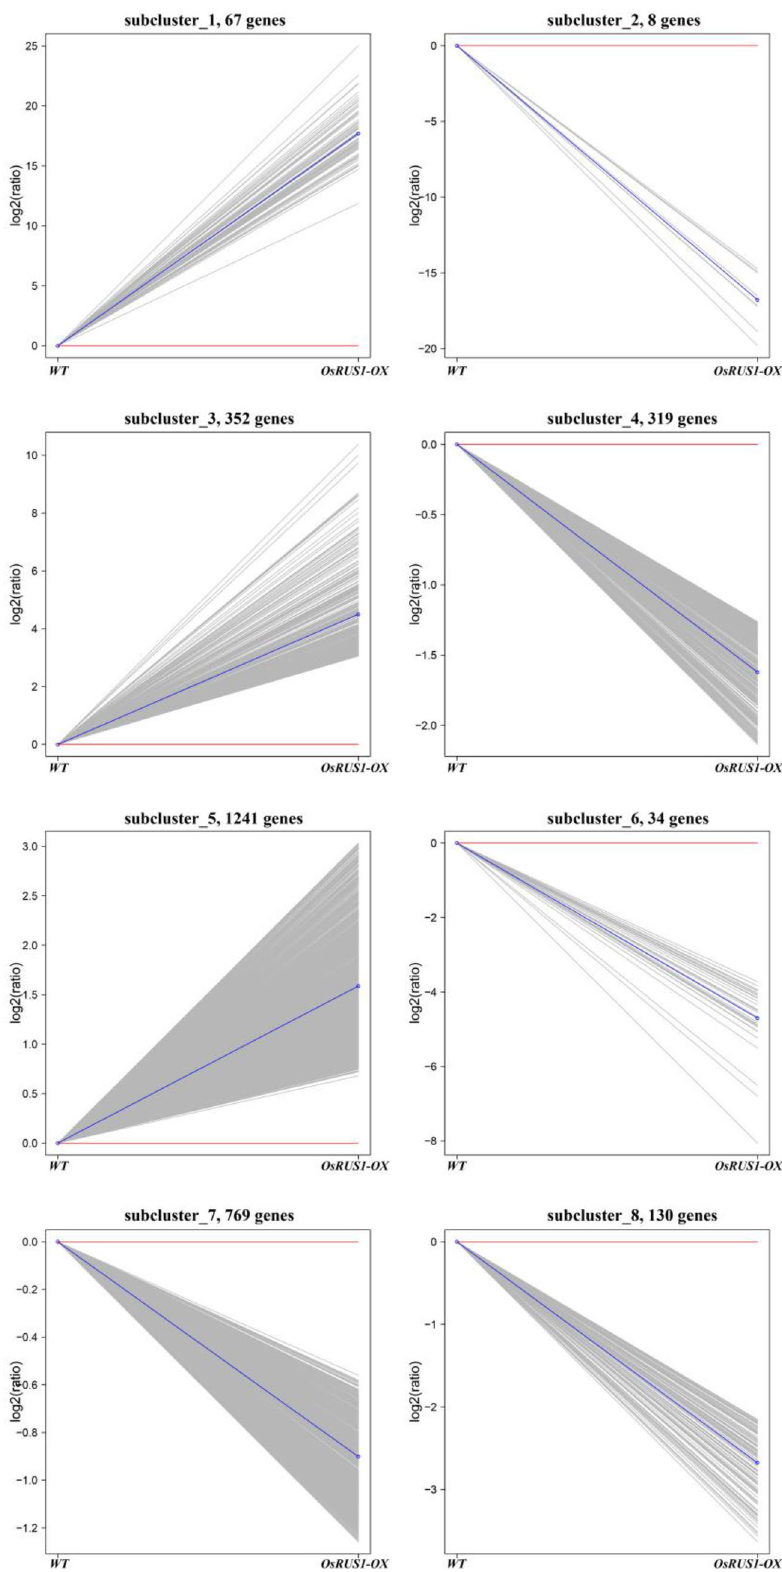
Figure 4. The k-means clustering of differentially expressed genes between WT and OsRUS1-OX . The eight major clusters obtained by K-means algorithm, representing upregulated (1, 3, 5), and downregulated (2, 4, 6, 7, 8) clusters. Expression ratios are expressed as Log 2 . WT, the wildtype of ZhongHua11; OsRUS1-OX , the OsRUS1-GFP Overexpression transgenic